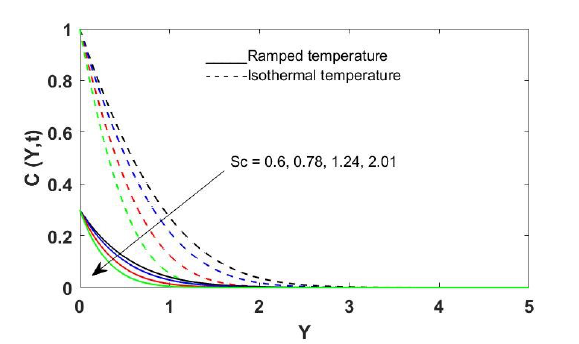
Figure 17: Concentration profiles for different values of Sc, where t =0.3, K=1